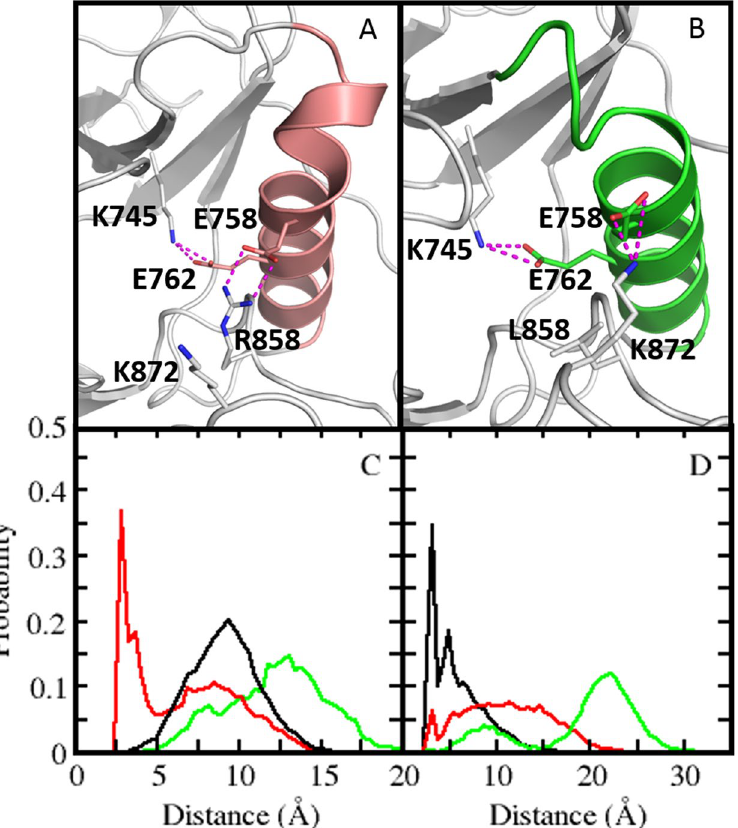
Figure 1. Mechanism of activation of the EGFR L858R and EGFR 19del . Snapshot of EGFR L858R (top left) and EGFR 19del (top right highlighting the catalytically important salt bridge/interactions between K745 and E762 and a new interaction observed between R858 and E758 during the MD simulations. Probability distributions of distances ( A ) R858-E758 ( B ) K872-E758 sampled during MD simulations of EGFR WT , EGFR L858R and EGFR 19del .